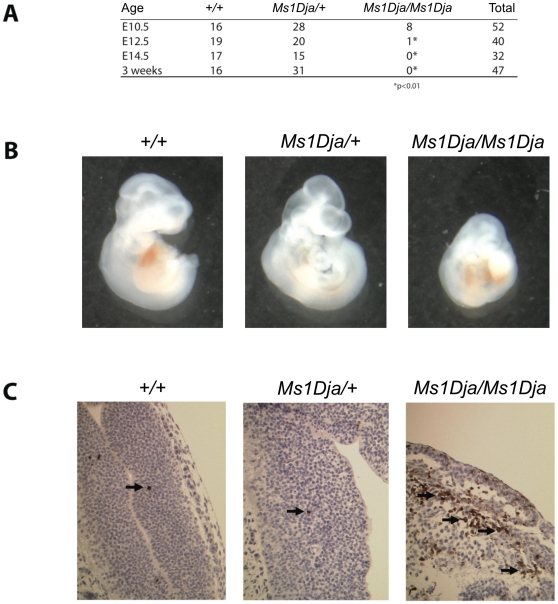
Embryonic lethality of mice homozygous for the Lipi-Usp25 deletion.(A) Genotyping of E10.5, E12.5, E14.5 embryos, and 3-week old mice from monosomic Ms1Dja intercrosses. Asterisk indicates P<0.01 (Chi-square test). (B) Photos of wildtype (+/+), monosomic (Ms1Dja/+) and nullisomic (Ms1Dja/Ms1Dja) embryos at E10.5. Longitudinal measurements are 4 mm, 4 mm and 2.7 mm for the wildtype, monosomic and nullisomic embryos, respectively. (C) Immunohistochemical analysis using a Cleaved Caspase-3 (Asp175) antibody showed markedly increased number of apoptotic cells (brown staining; highlighted by black arrows) in the neural tube of nullisomic (Ms1Dja/Ms1Dja) E10.5 embryos. Images are representative and taken at ×200 magnification.